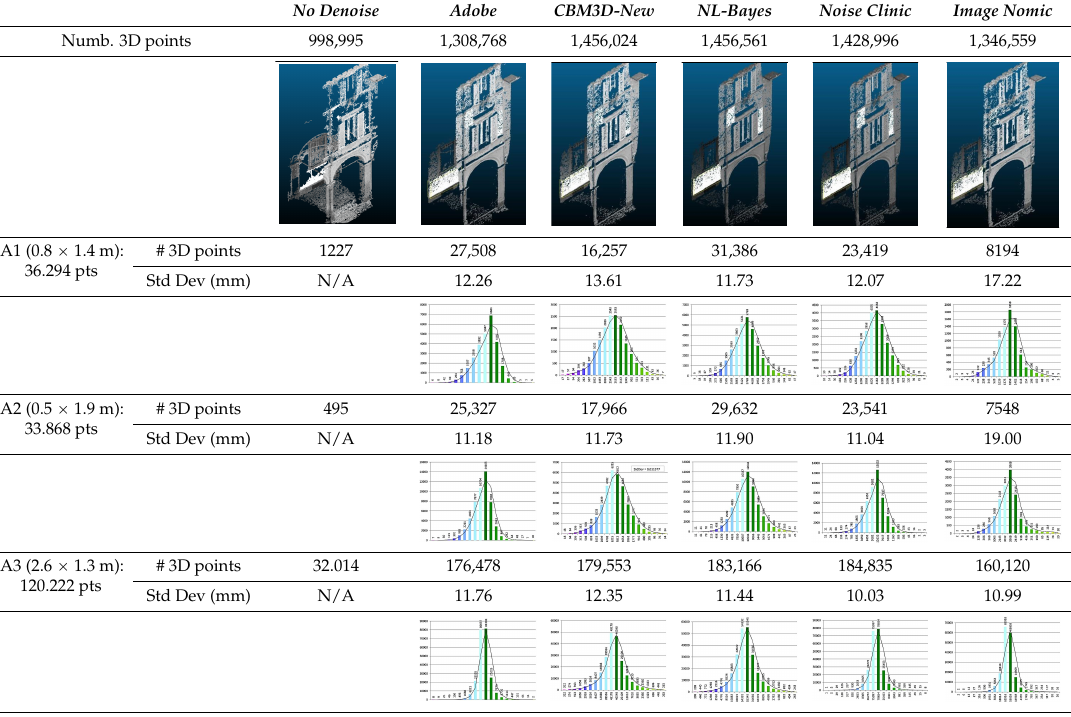
Table 4. Evaluation of the denoising procedures on the dense matching phase. The ground truth is given by a TLS survey resampled to 5 × 5 mm grid. The histograms of the cloud-to-cloud point distribution errors are also reported. No Denoise Adobe CBM3D-New NL-Bayes Noise Clinic Image Nomic Numb. 3D points